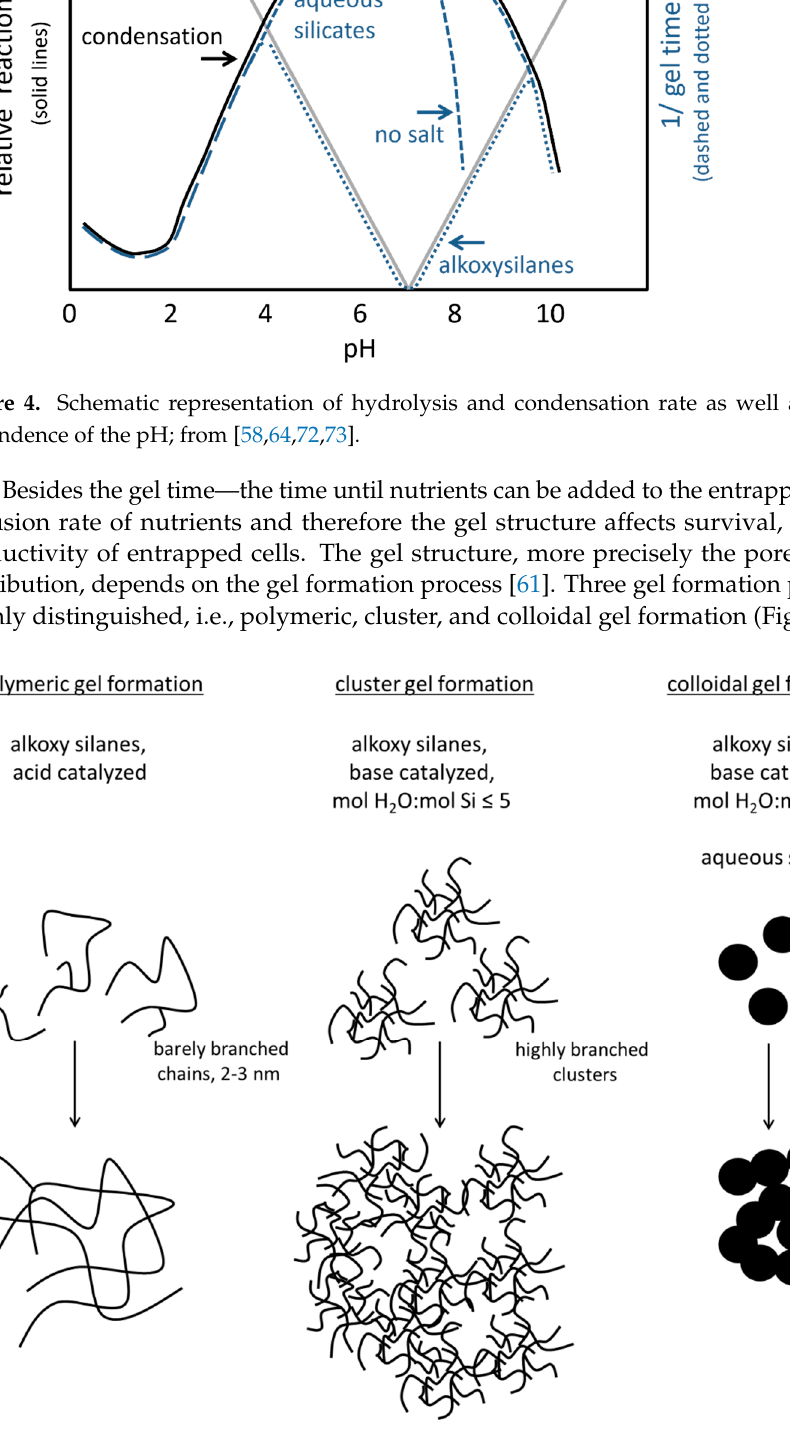
Figure 5. Schematic presentation of the polymeric, cluster, and colloidal gel formation, modified from [60,61,64].